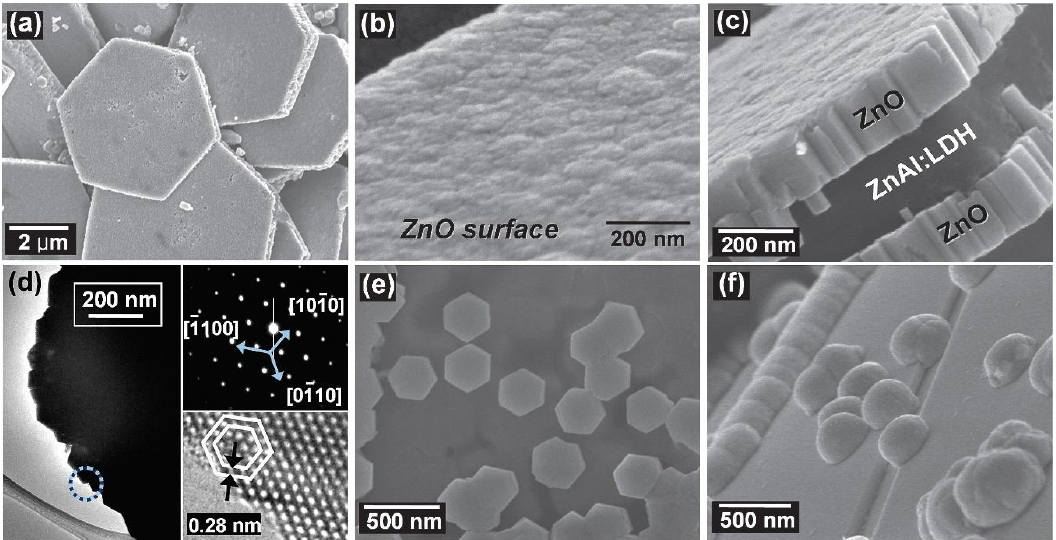
Figure 31. SEM images of hexagonal ZnO film/ZnAl:LDH heterostructures: ( a ) low magnification; ( b ) high-magnification image of the surface of the ZnO film; ( c ) high-magnification image of the side of the ZnO film/ZnAl:LDH heterostructures; ( d ) TEM image of a hexagonal ZnO film/ZnAl:LDH heterostructure. A corresponding electron diffraction (SAED) pattern and a HRTEM image of the point marked by a circle are inserted as the upper and lower insets, respectively; SEM images of the less dense ZnO nucleation areas of the heterostructures: ( e ) plan view; ( f ) oblique view. Republished with